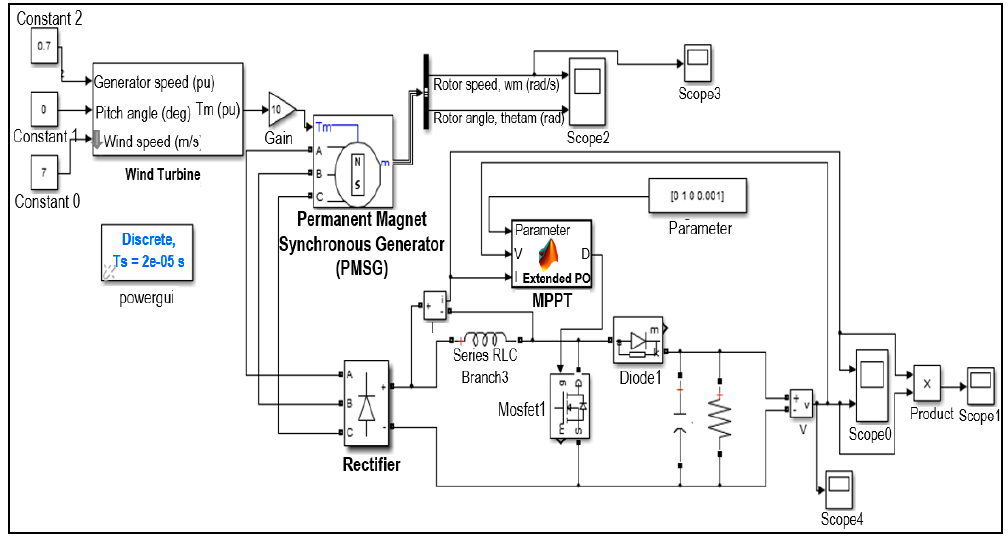
Figure 12. Wind-turbine system without MPPT in Simulink-Matlab software.